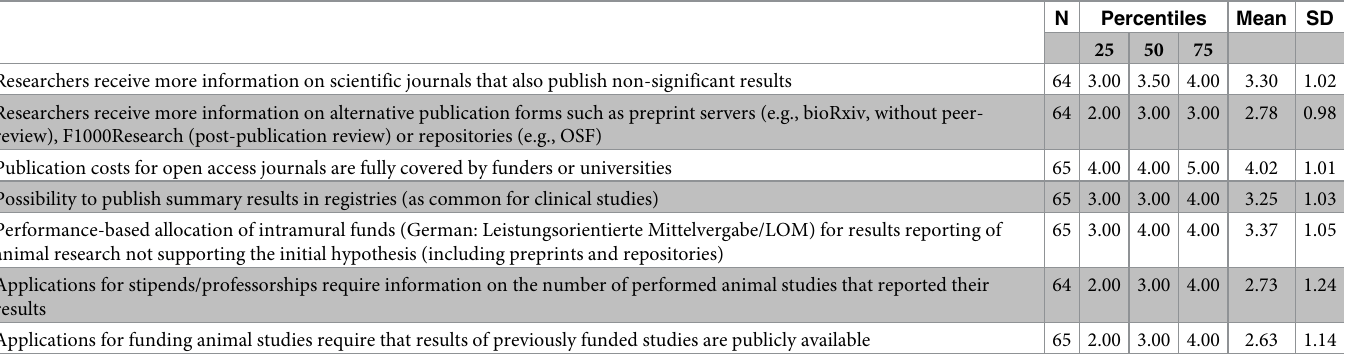
Table 2. Ratings of approaches to increasing results publication of animal studies.